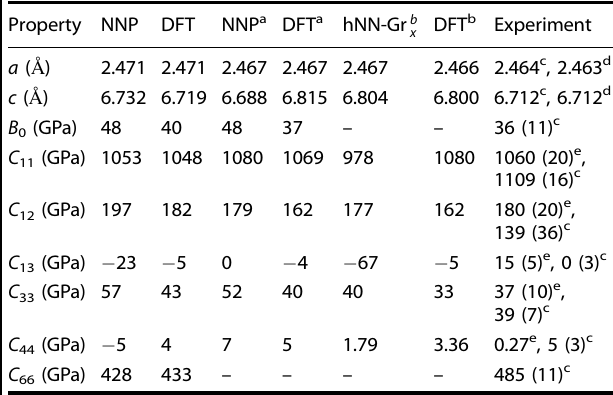
Table 3. Elastic properties of graphite. Property NNP DFT